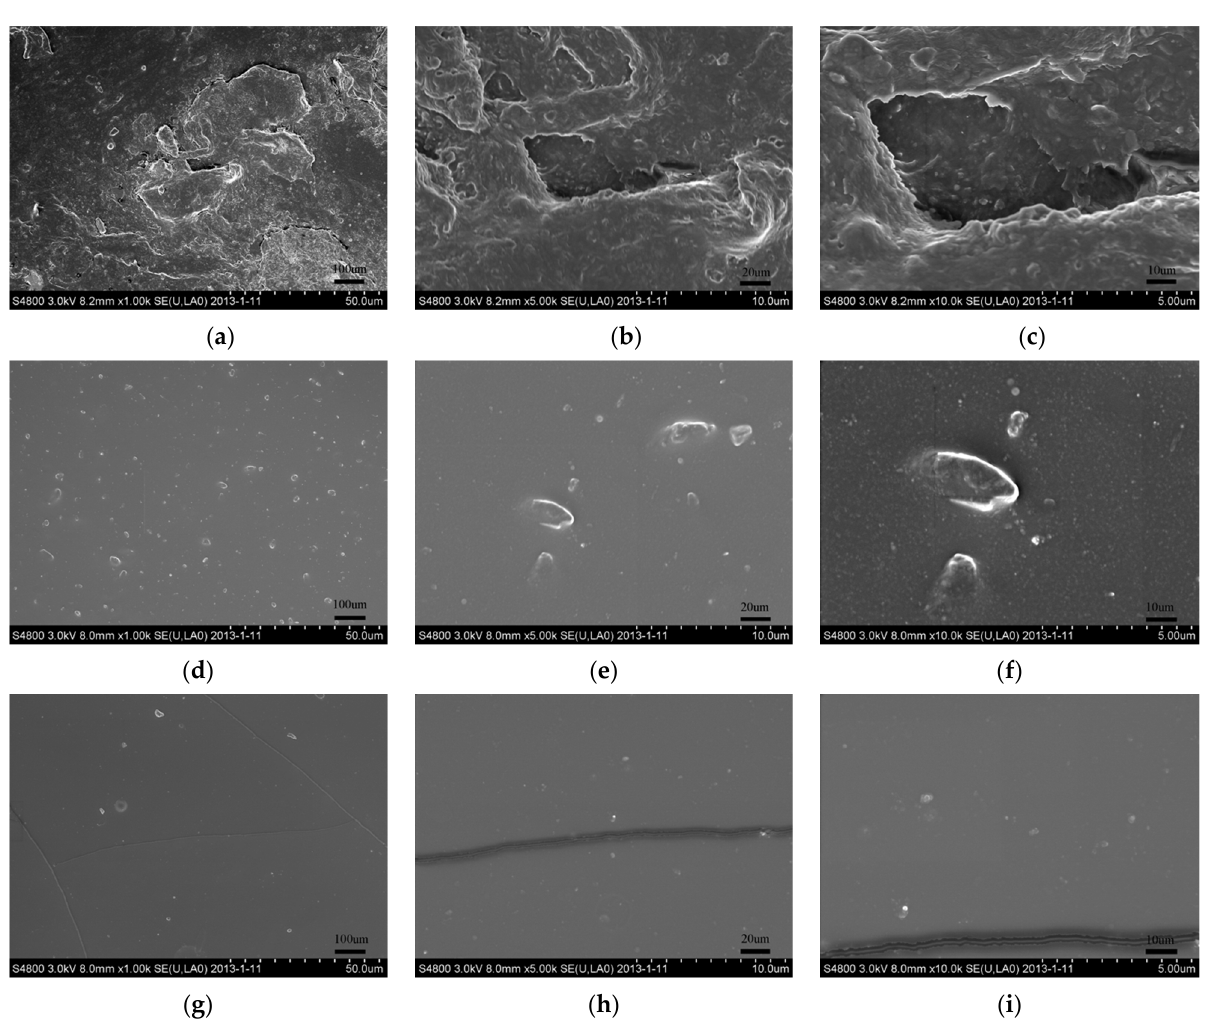
Figure 12. SEM figures of the insulation surfaces. ( a – c ) Polymer. ( d – f ) Coating A. ( g – i ) Coating B. Table 2. Trap parameters of the dielectric materials measured by TSC test. Table 2. Trap parameters of the dielectric materials measured by TSC test. Parameter Parameter Polymer Coating